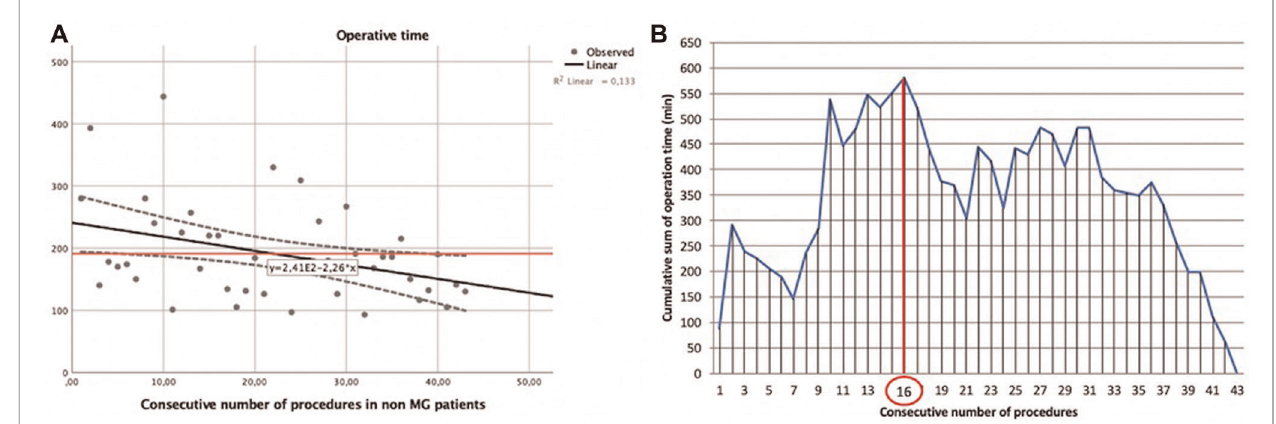
FIGURE 4 | Learning curve of robot-assisted non-myasthenic thymectomies. ( A ) Correlation between the operation time and the consecutive number of procedures [the red line represents the average time; the Pearson correlation coef fi cient ( r ) of linear function is − 0.365]; ( B ) cumulative sum (CUSUM) plot for the overall surgical time. The red circle is the CLC cut-off value on the plot of CUSUM analysis. CLC, completion of learning curve.